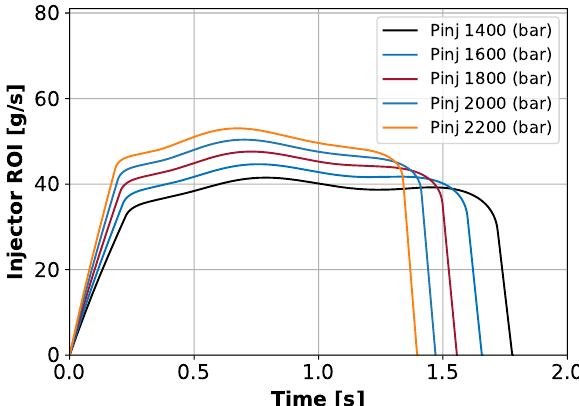
Figure 6. Virtual injector model: a comparison between several values of injection